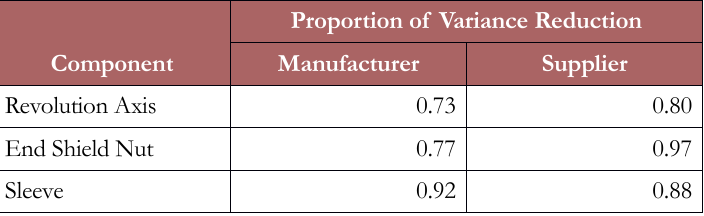
Table 9. Proportion of Variance Reduction at second cycle